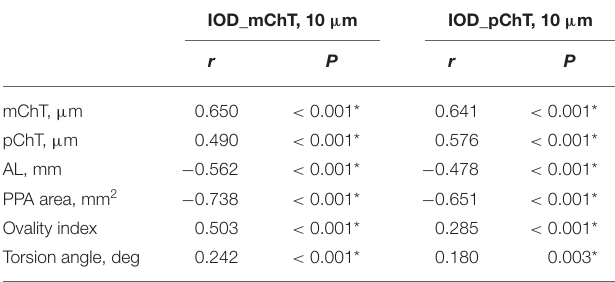
TABLE 2 | Correlation analysis between constructed IODs with clinical features in the test